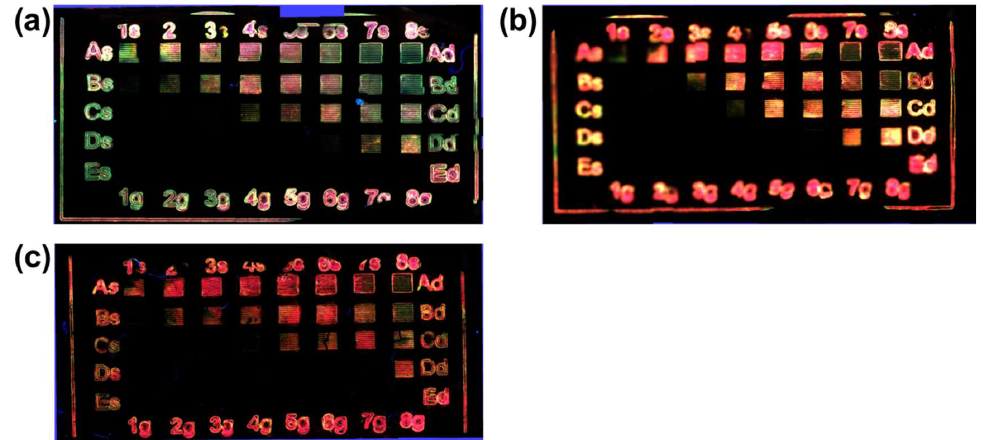
Figure 4. Photo of the laser treated film under epi-fluorescent microscope (excitation with UV filter) with different Cd(ISA) 2 concentrations: ( a ) 40 mg/mL, ( b ) 80 mg/mL and ( c ) 120 mg/mL. The PMMA concentration is fixed at 300 mg/mL. The side square is 1 mm.